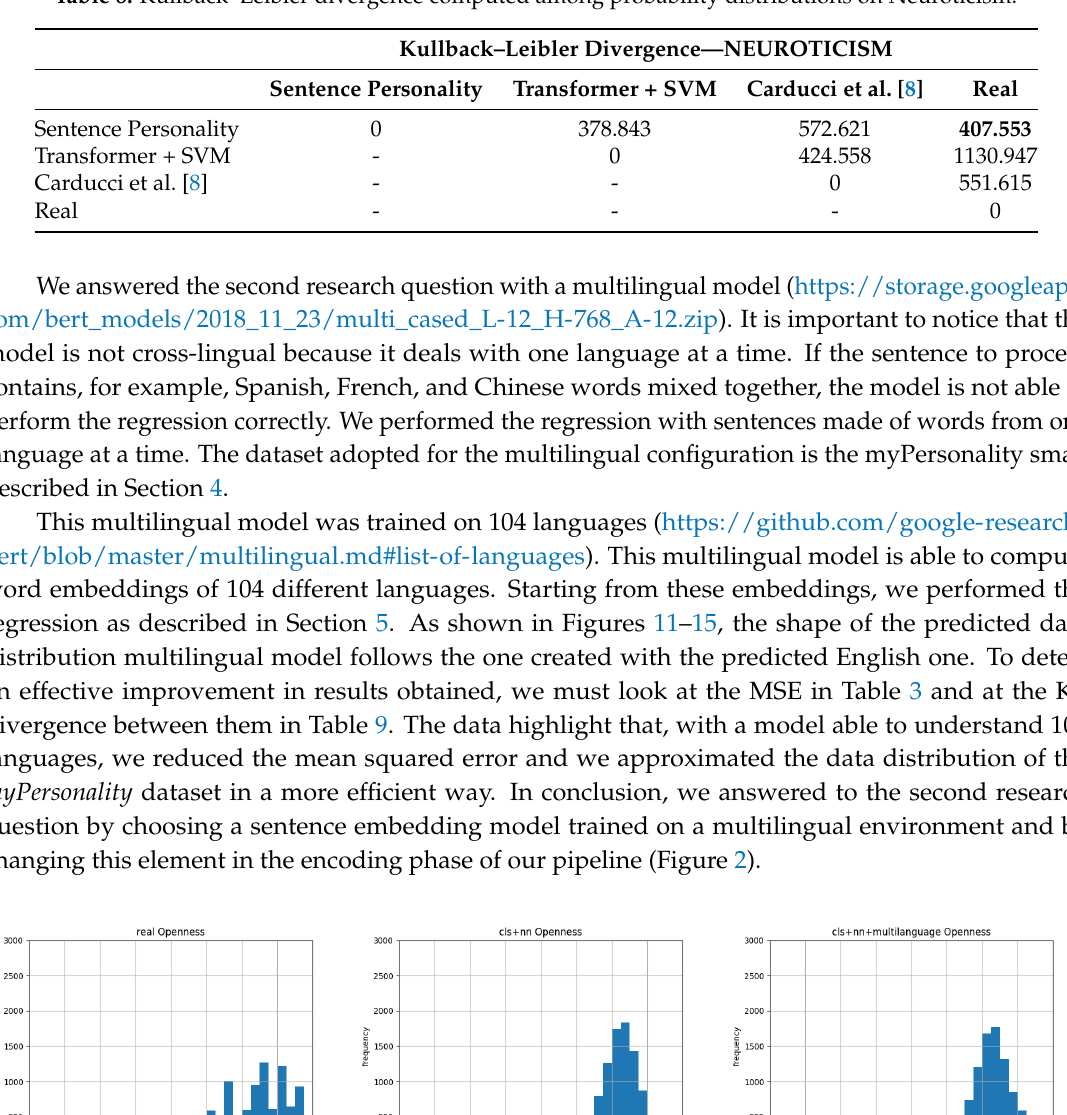
Table 8. Kullback–Leibler divergence computed among probability distributions on Neuroticism.